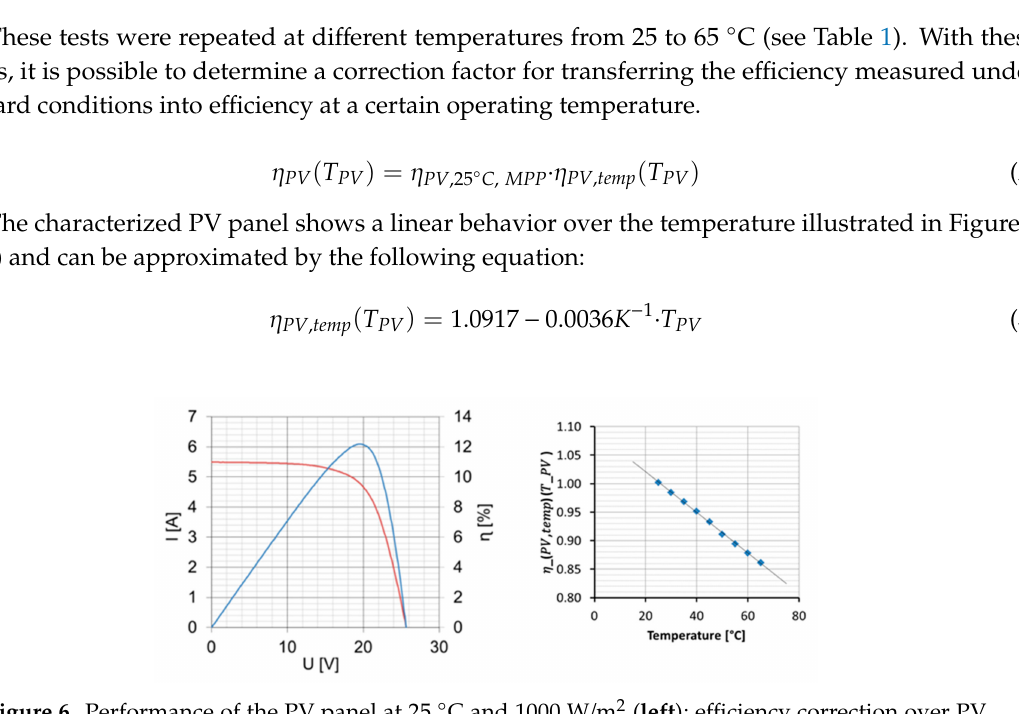
Figure 6. Performance of the PV panel at 25 ◦ C and 1000 W / m 2 ( left ); e ffi ciency correction over PV panel temperature ( right ).